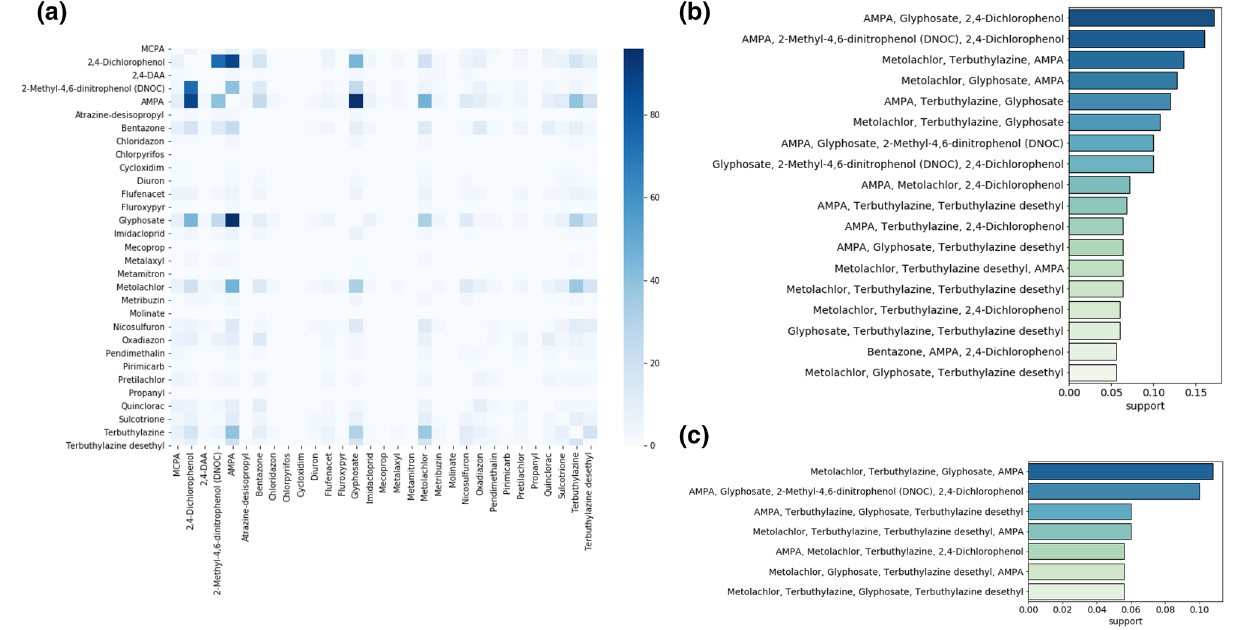
Figure 3. Clusters of substances in surface waters. ( a ) Substance cross-correlation matrix showing the number of times two substances (herbicides or insecticeds) have been found together in the same location and at the same time both with c > c 0 = 0.1 μg/l. The heatmap was created using python3.7 and the seaborn (0.11.0) package (https:// seabo rn. pydata. org/). ( b ) Fraction of instances in which three substances have been recorded (all with c > c 0 ) in the same location at the same time. ( c ) Fraction of instances in which four substances have been recorded (all with c > c 0 in the same location at the same time).